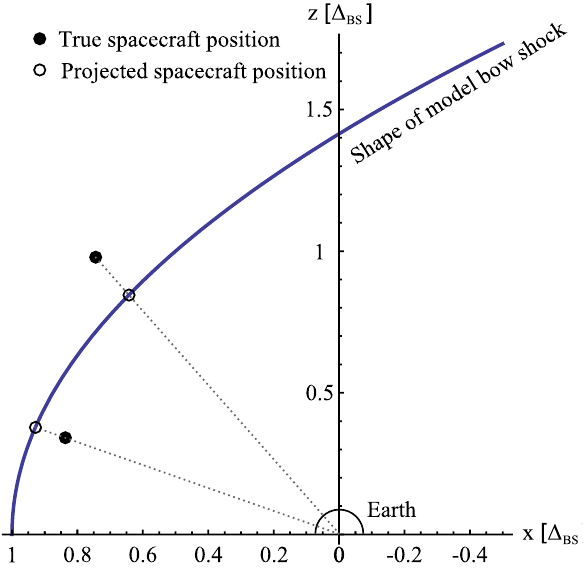
Figure 4. Sketch of the model bow shock used as a reference bow shock for data presentation. The dotted lines show example projec- tions of two different currents from their true location to the location at the reference bow